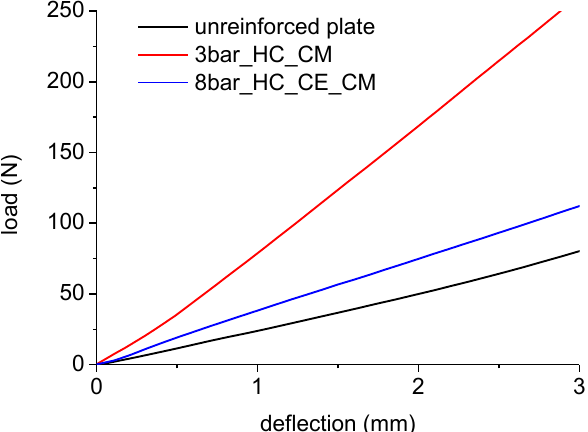
Figure 7. Force–deflection curves from plate bending tests on samples extracted from rotomolded prototypes.